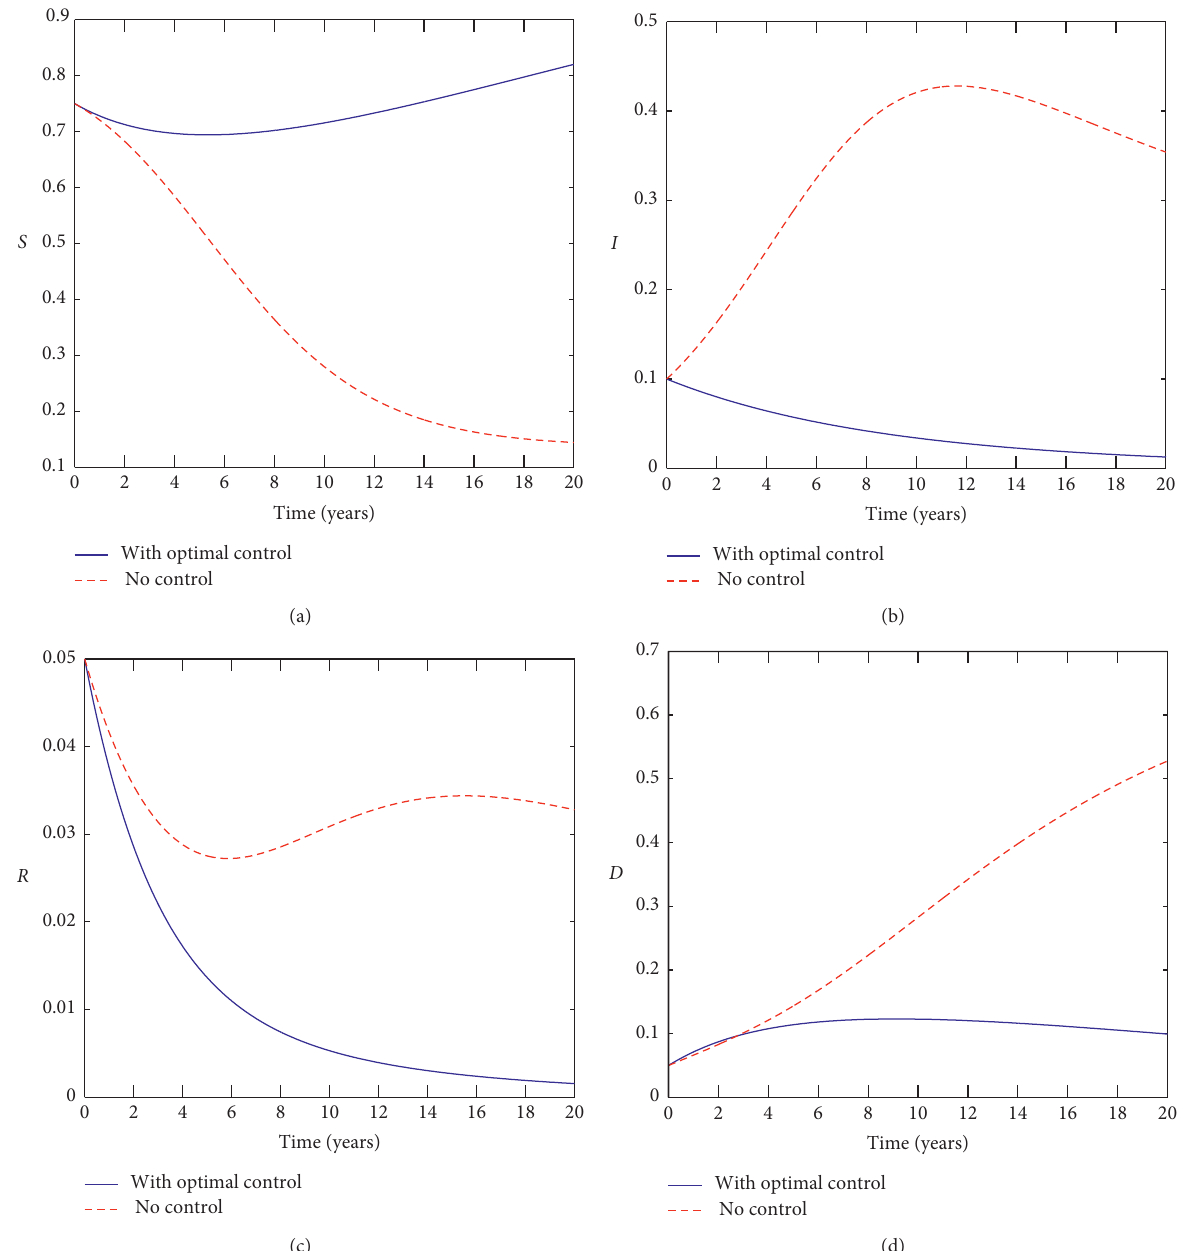
Figure 3: Graphs of the numerical solutions of the optimality system, showing the propagation of (a) susceptible population S , (b) infectious who are not on treatment I , (c) infectious on treatment and no longer having sex with other men R , and (d) infectious on treatment and being a bit more careful when having sex D , over a period of 15